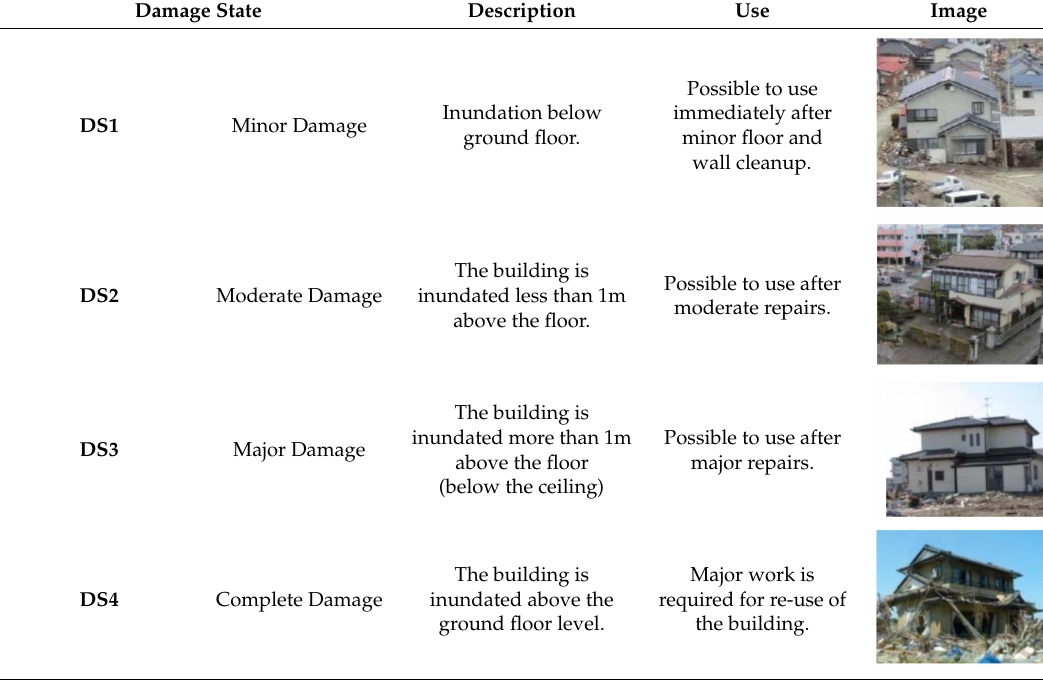
Table 1. Damage state definitions used by the Japanese Ministry of Land Infrastructure Tourism and Transport following the 2011 Great East Japan Earthquake and Tsunami. Descriptions from [14], usage descriptions are after